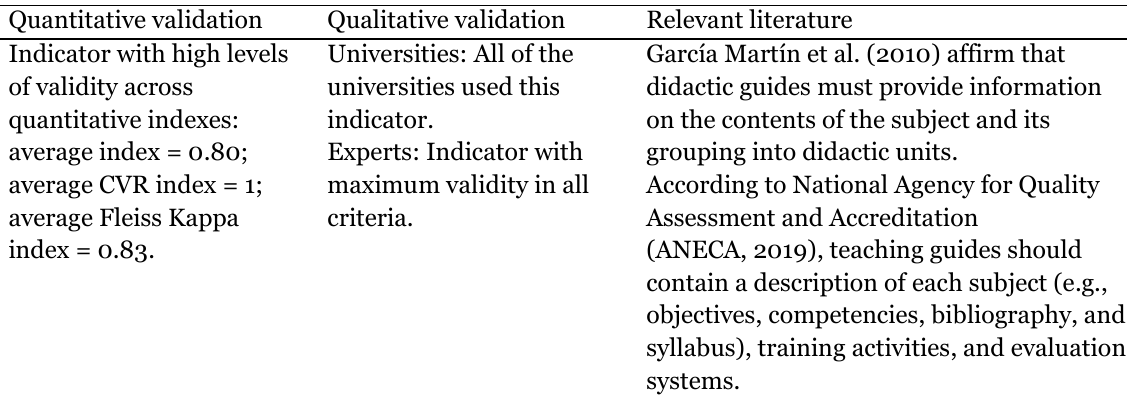
Triangulation of Results for Indicator 29: The Didactic Guide Includes the Thematic Contents of